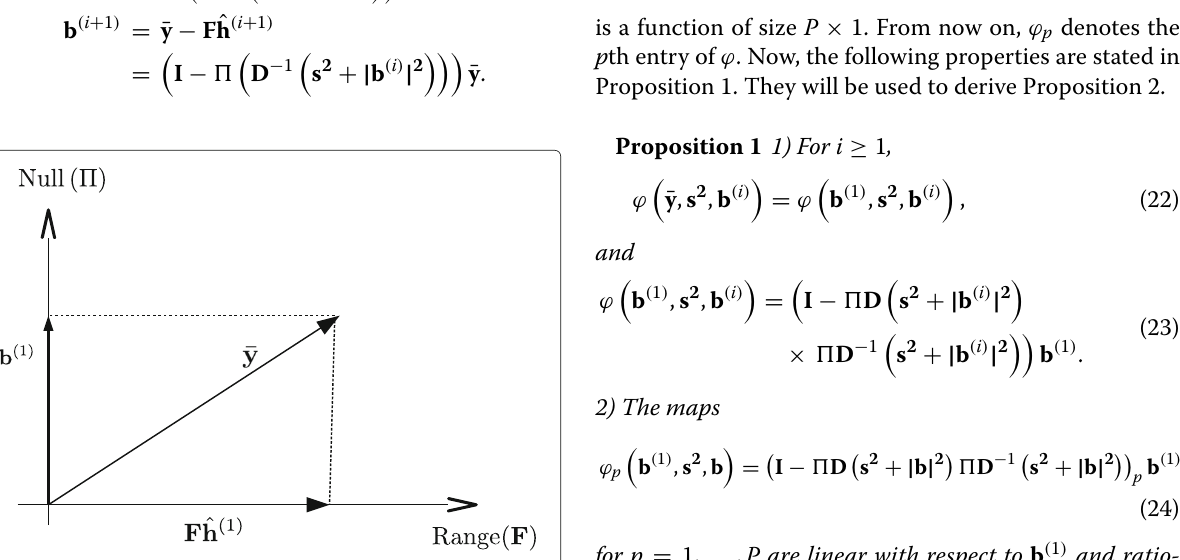
Fig. 1 First iteration of the CML algorithm: orthogonal projection